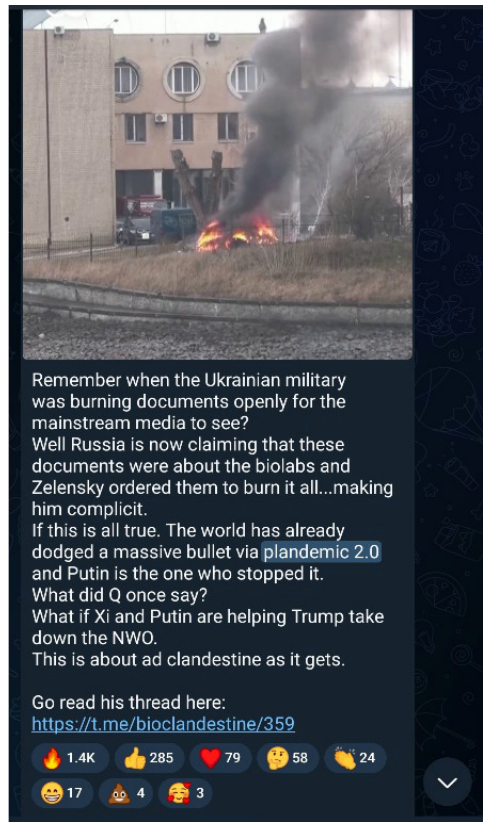
Figure 1. ULTRA Pepe Lives Matter: Ukrainian documents are